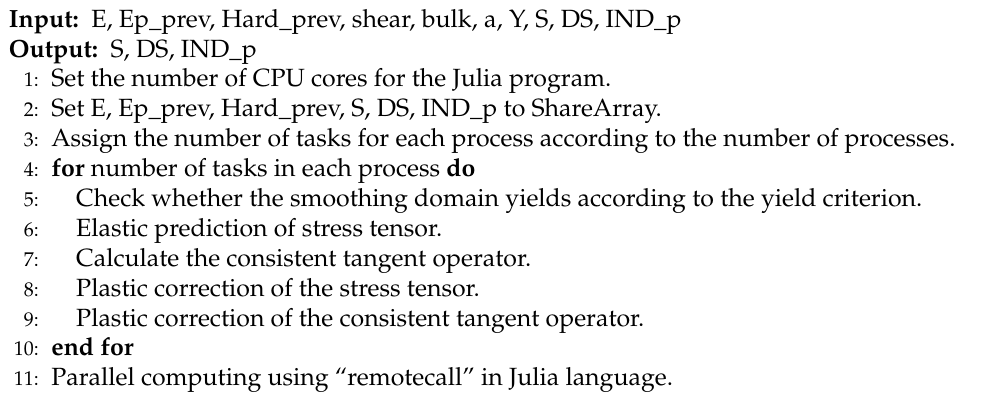
Algorithm 2 Parallel implementation of implicit Von Mises constitutive integral algorithm